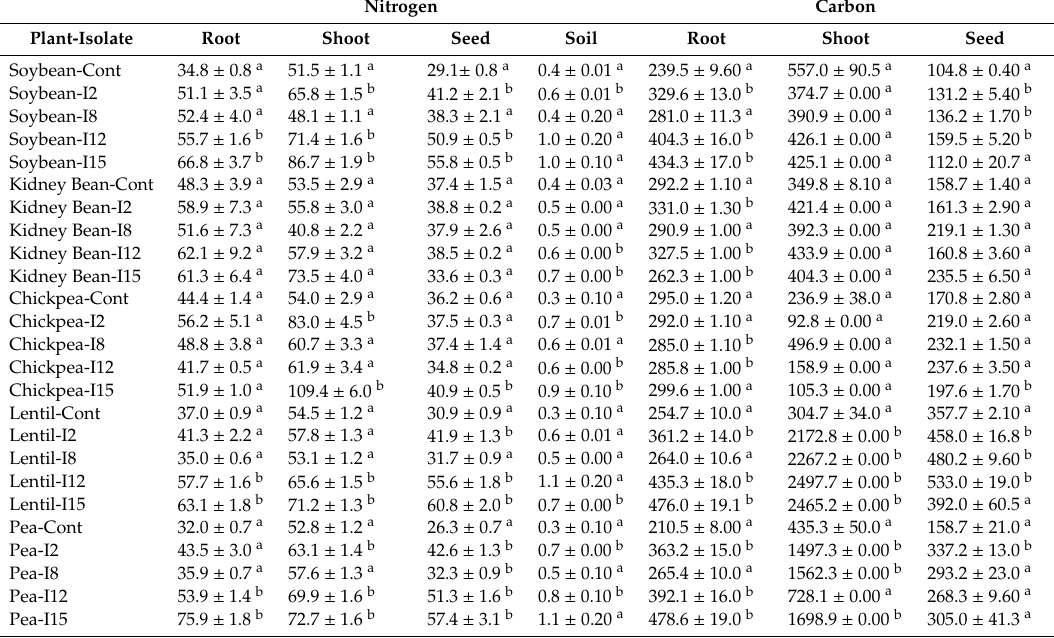
Table 1. Changes in nitrogen and carbon content (mg / g) of shoots, roots, seeds as well as soil of soybean, kidney bean, chickpea, lentil, and pea under control (cont.) and after enrichment with the biologically active actinomycete isolates. Values are the average of three individual replicates (means ± S.D). Di ff erent letters represent significant di ff erences between the treatments in each crop (Duncan test; p < 0.05; n =